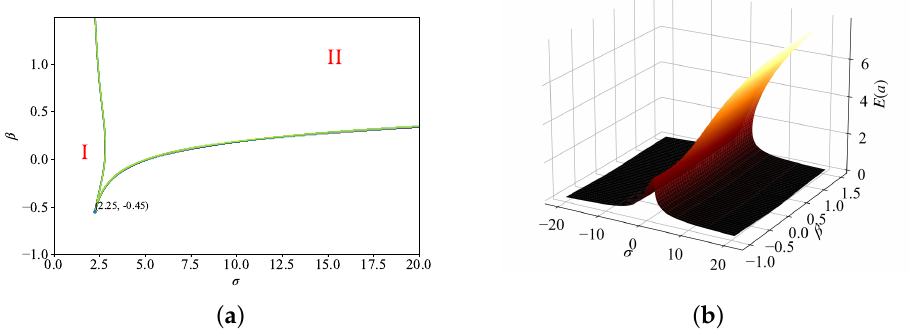
Figure 5. Bifurcation diagrams of the steady-state E ( a ) with different σ and β . ( a ): variations of E ( a ) in two dimensional plane. ( b ): variations of E ( a ) in three dimension space.